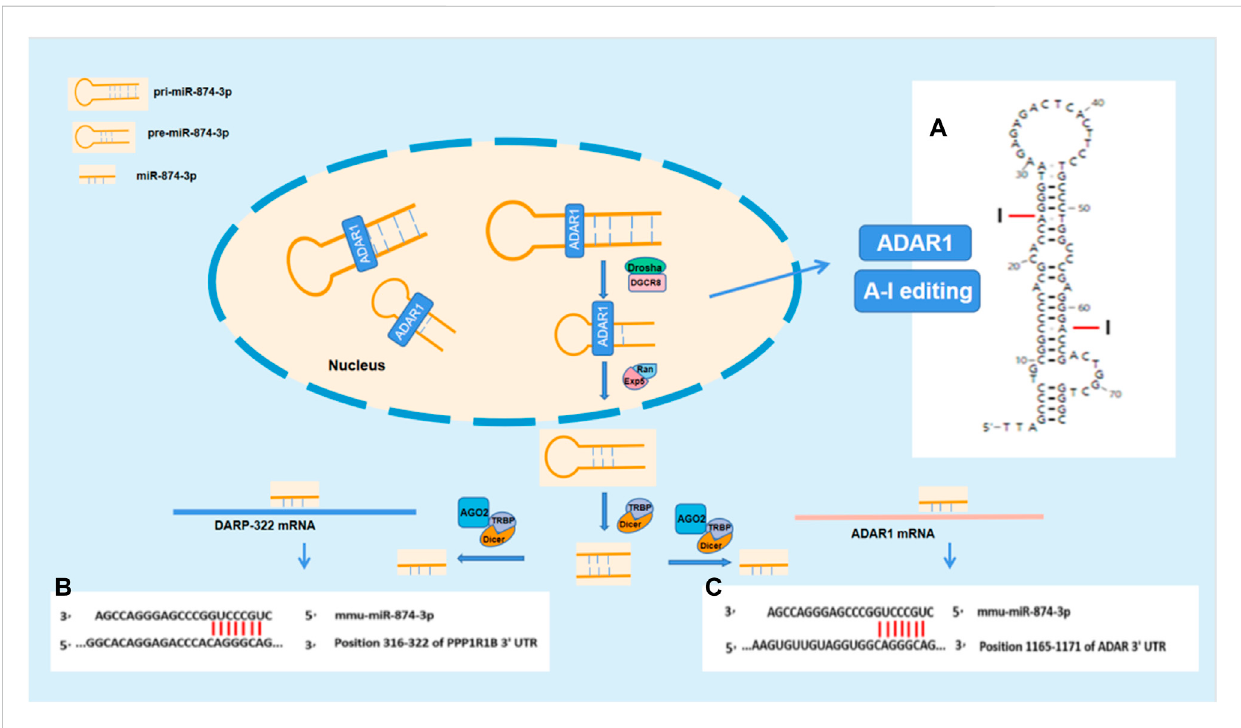
FIGURE 5 ADARl impacts DARPP-32 by acting on miR-874-3p. (A) The stem – loop structure of mmu-pre-miR-874 and the potential A-I editing sites; (B) and (C) showthepotentialbindingsitesforRNAinterferencebetweenmiR-874-3pandADAR1mRNAorDARP-32 mRNA,respectively. (B) Mmu-miR-874-3p contains seven sites binding to 3 ′ UTR of ADAR mRNA; (C) mmu-miR-874-3p contains seven sites binding to 3 ′ UTR of DARPP-32